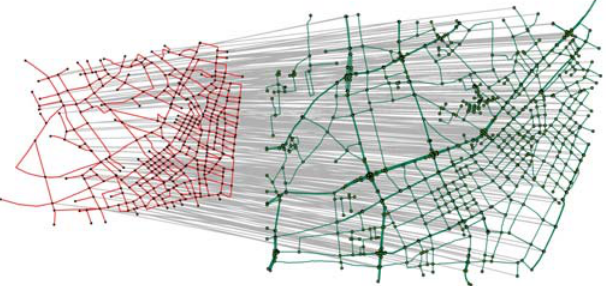
Figure 3. Results of global structure extraction in Wuhan City